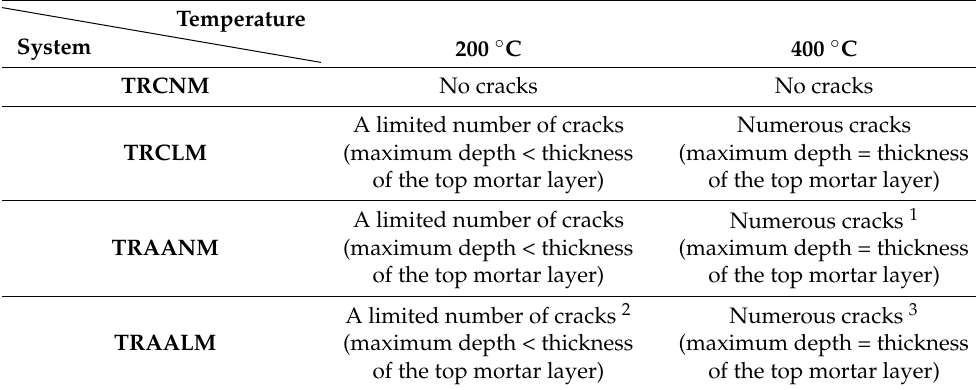
Table 5. The cases of crack formation on the top mortar layer of the TRM overlay due to specimens heating.